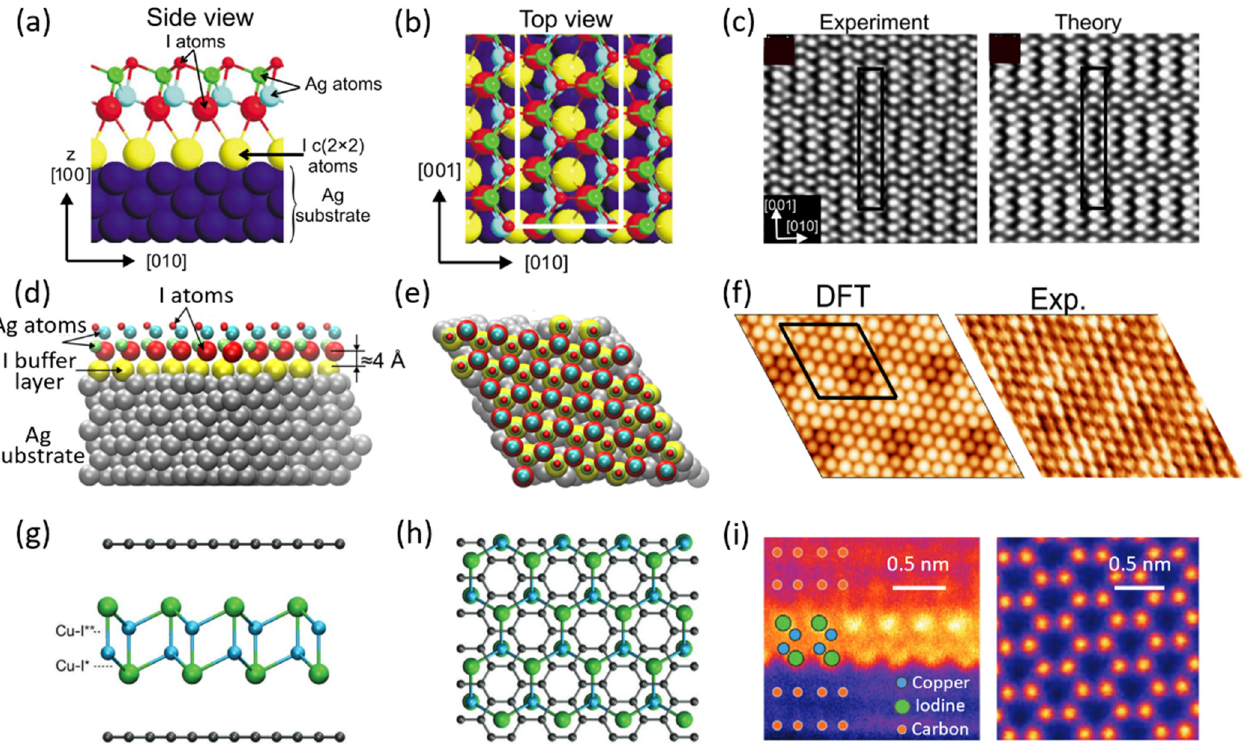
Figure 3. ( a ) Side and ( b ) top views of the sandwich-like AgI film on Ag(100) surface. ( c ) Theoretical and experimental simulated STM images of the AgI with a distorted DLHC structure (U s = − 260 mV). Reproduced with permission [36]. Copyright 2009, American Physical Society. ( d ) Side and ( e ) top views of AgI film on Ag(111) surface. ( f ) Comparison of theoretical and experimental STM images of the surface (Us = − 500 mV). Reproduced with permission [37]. Copyright 2022, AIP Publishing. ( g ) Side and ( h ) top views of CuI sandwiched by graphene layers. The “Cu–I*” and “Cu–I**” mean the in-plane and out-of-plane bonds, respectively. ( i ) Cross section STEM and top high-angle annular dark-field (HAADF) images of the synthesized 2D CuI. Reproduced with permission [38]. Copyright 2022, John Wiley and Sons.